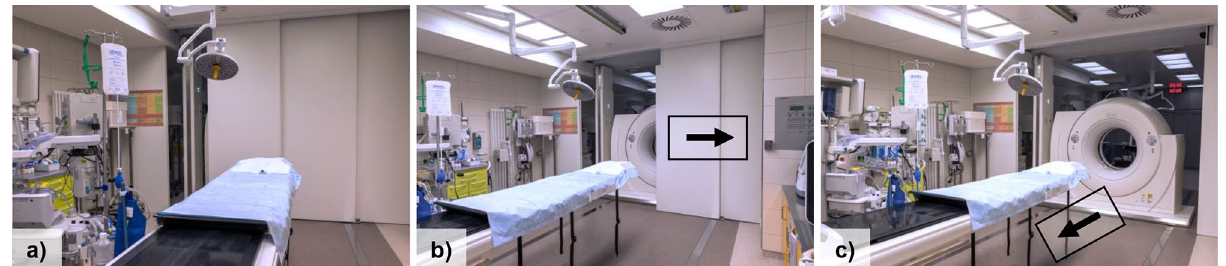
Figure 1. Illustration of the dual-room trauma suite setup with a single sliding gantry-based CT scanner. ( A ) Depicts one trauma suite with removed CT scanner. The sliding door separating both suites while providing radiation protection can be opened ( B ) and the sliding gantry approaches the stationary patient in order to perform the CT scan.